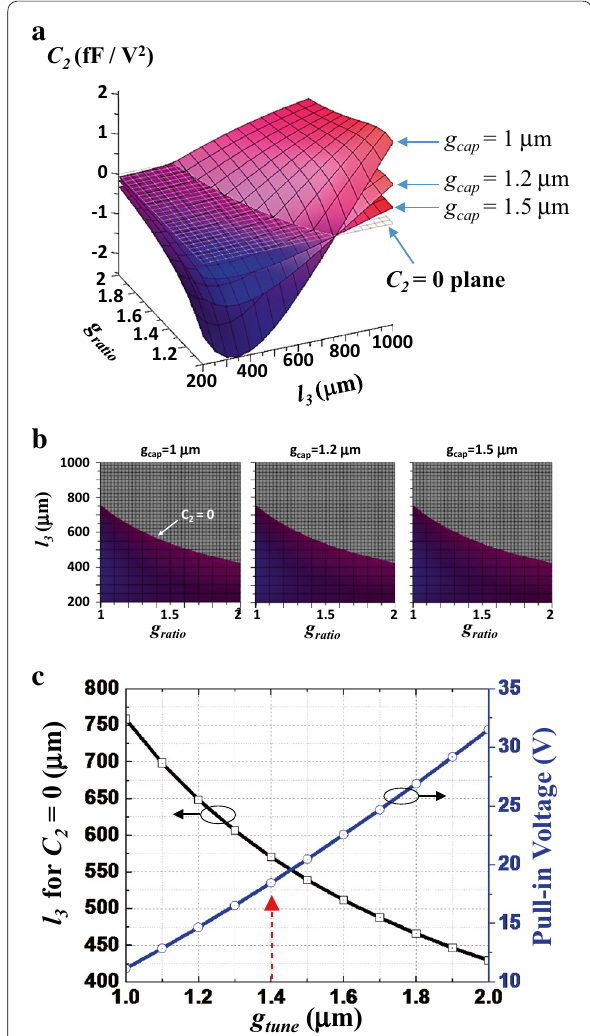
Fig. 3 Analysis of parameters that determine the linearity of C–V response. a 3D plot for the coefficient of second order term in Taylor series. b Top view of ( a ) showing the cross points with C 2 are the same in every case. c l 3 and pull‑in voltage in the case of g cap 1 =